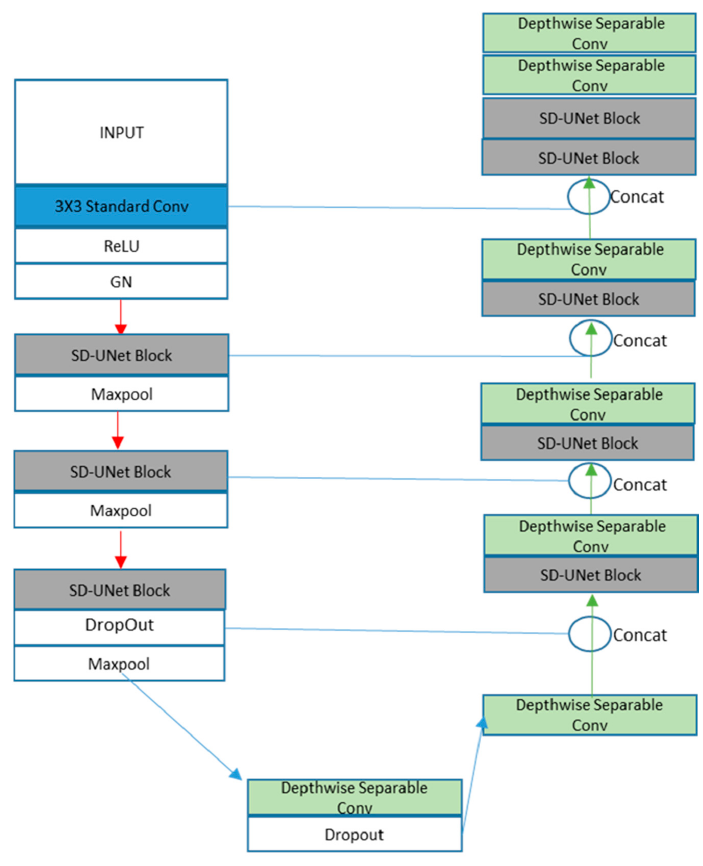
Figure 6. SD-UNet Architecture.